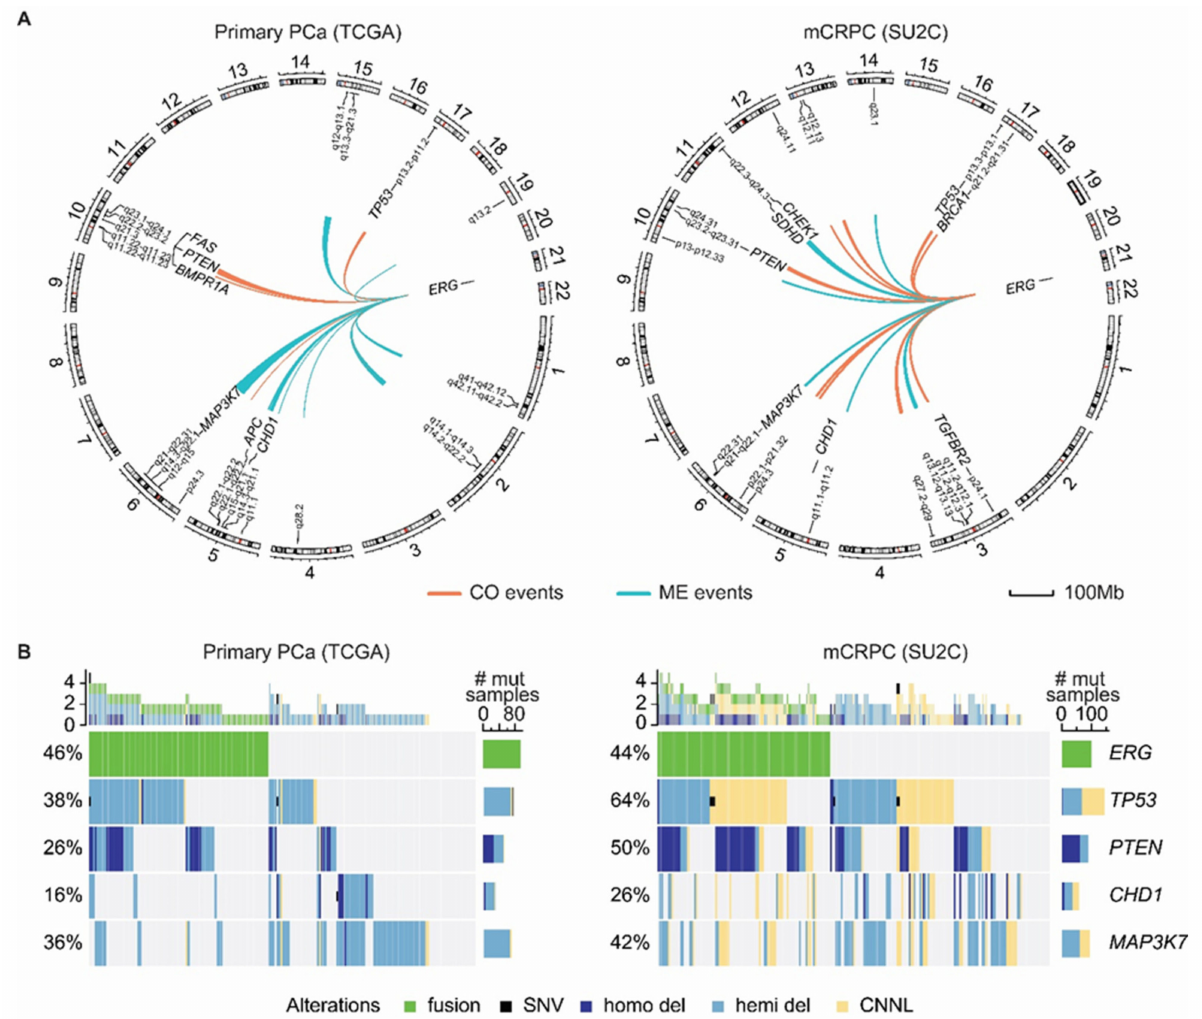
Figure 2. Mutually exclusive (ME) and co-occurrent (CO) genomic events with TMPRSS2-ERG fusion in PCa. ( A ) Circos plot of mutual exclusive and co-occurrent genomic events with TMPRSS2- ERG fusion in primary PCa (TCGA, left ) and mCRPC (metastatic castration resistant PCa) (SU2C, right ) datasets identified by FaMe (Fast Mutual Exclusivity) [185] upon in-house processing of genomic data at allele-specific levels. Single nucleotide variants (SNVs), hemizygous (Hemi) and homozygous (Homo) deletions, and copy number neutral loss (CNNL) were queried against tumor sample fusion annotation status from the original reports [12,13]. Tumor suppressors and oncogenes within significant genomic segments are highlighted. ( B ) Oncoprint of the data in A for genes with literature-based